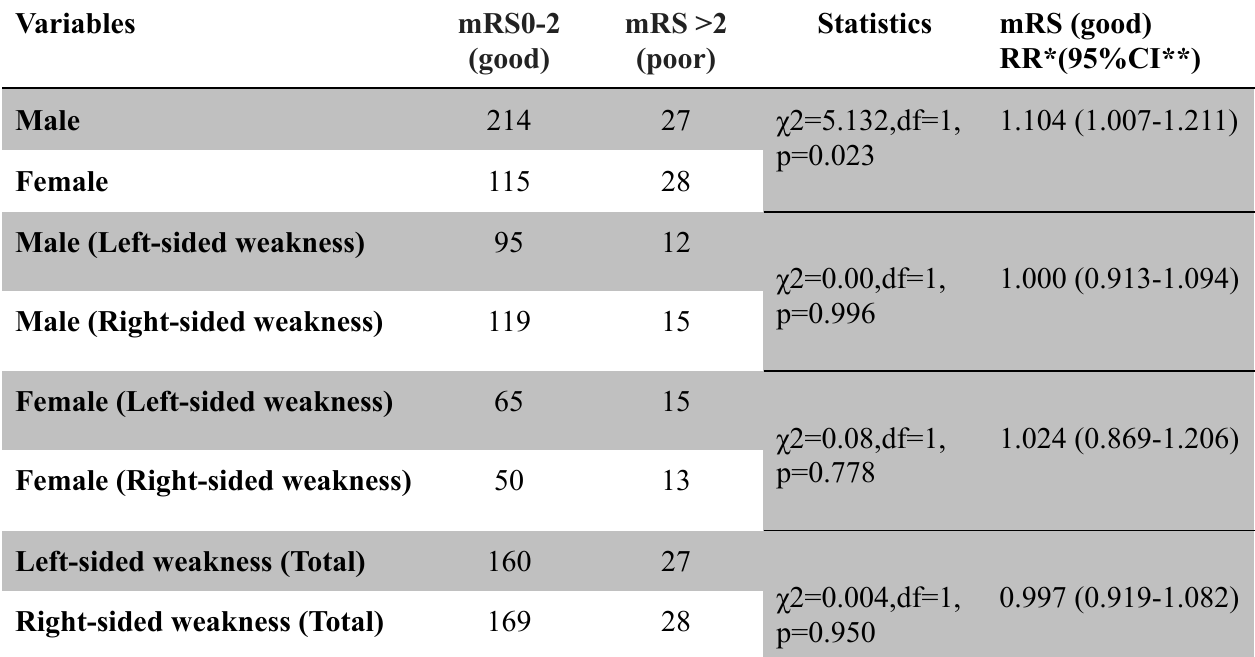
Table3: Association of sex and side of weakness with functional outcome [modified Rankin Score (mRS) good or poor] at